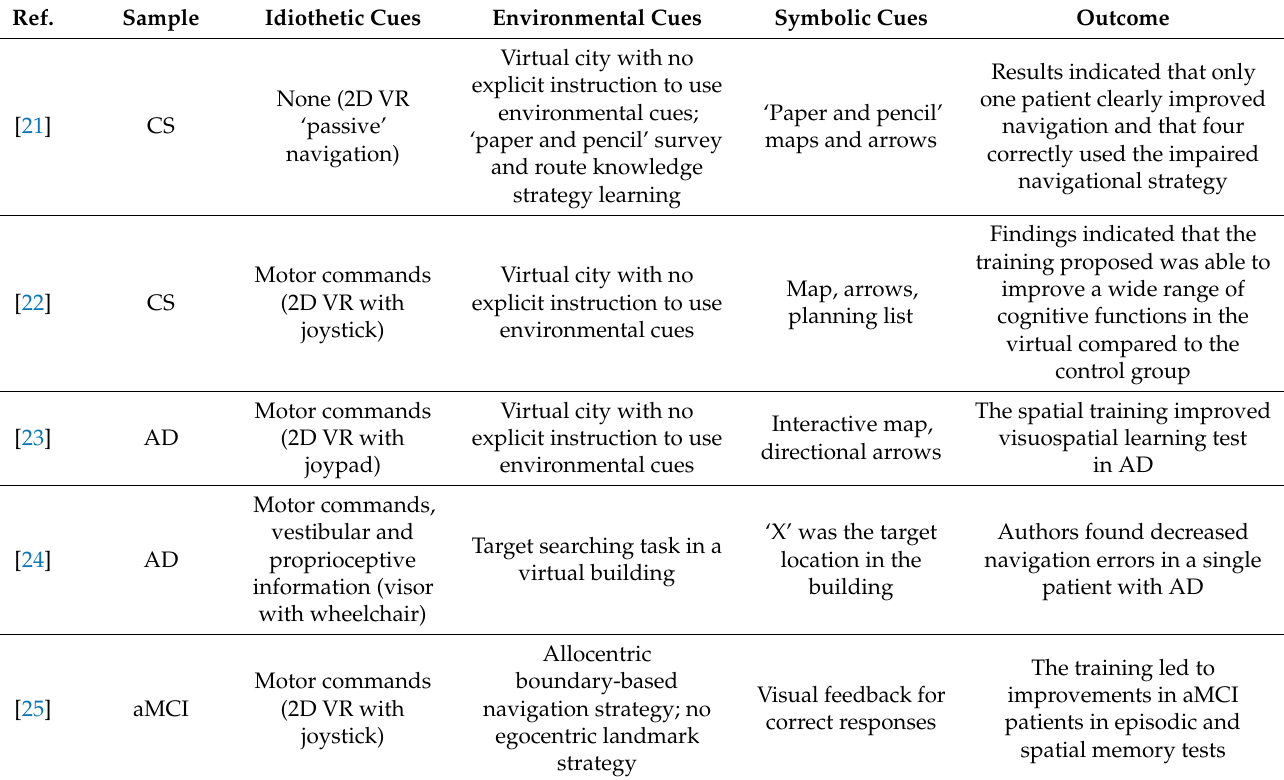
Table 1. Summary of the cues involved in virtual navigation training in aging and neurodegenerative disease.